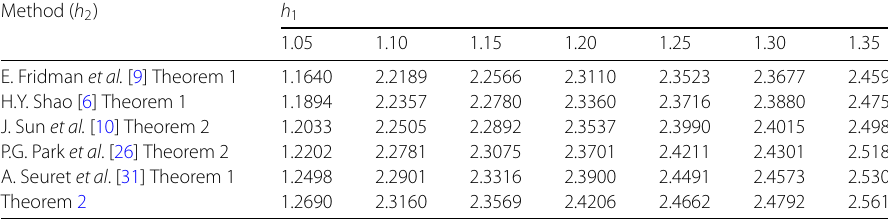
Table 2 The comparison results of upper bounds h 2 with different h 1 for μ = 0.2 (Example 2) Method ( h 2